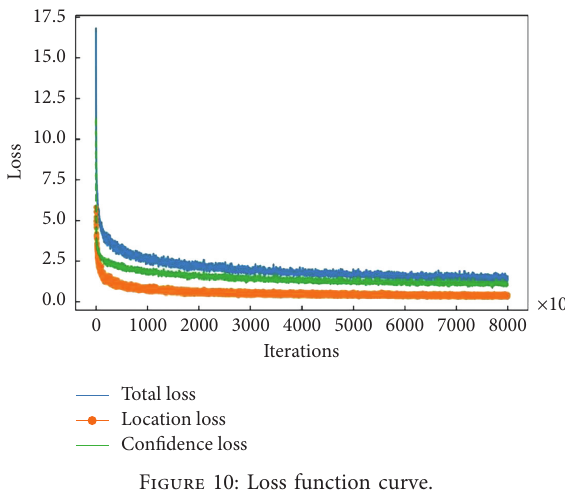
Figure 10: Loss function Table 1: Comparison of performance indexes between the improved SSD algorithm and other algorithms. Algorithm